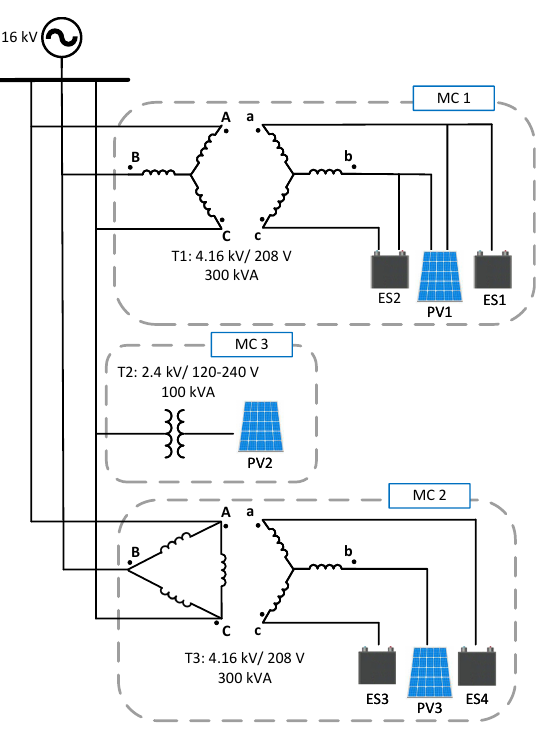
Figure 9. Multi-microgrid